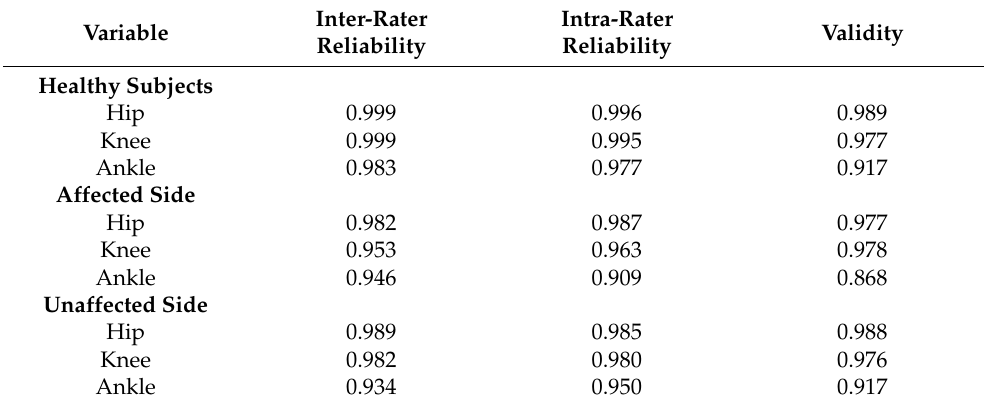
Figure 5. The lower limb kinematic curves measured by two systems for all participants. Significant differences between waveforms are indicated by the color bars under each graph. Blue color bars denote Odonate vs. Vicon on the Healthy Subjects, Affected Side, and Unaffected Side. Yellow, or- ange, and red color bars indicate the SPM independent − sample t − test results of each system for Healthy Subjects, Affected Side, and Unaffected Side, respectively. Table 2. CMC results of the Odonate system in lower limb kinematics.